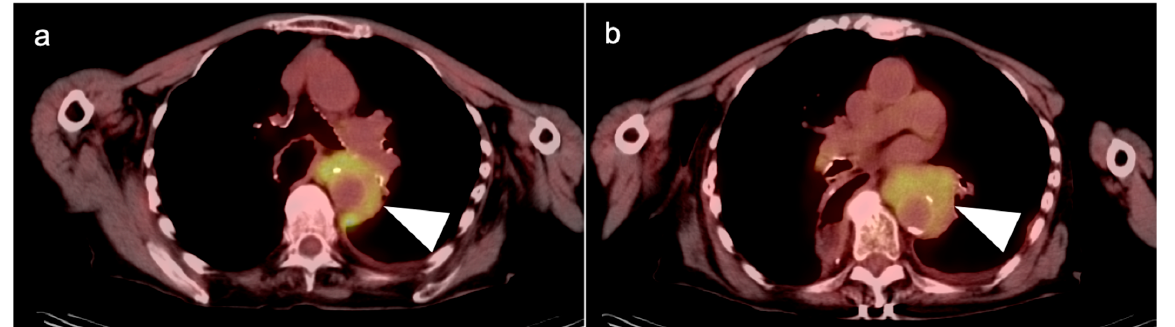
Figure 5. FDG PET-CT images of the upper abdomen in a patient with a GE junction esophageal cancer, ( a ) Axial fused FDG PET-CT show a GE junction tumor extending slightly into the gastric cardia (white arrowhead); ( b ) Axial fused FDG PET-CT image shows a typical pattern of nodal spread to lymph nodes in the gastrohepatic ligament (white arrow).